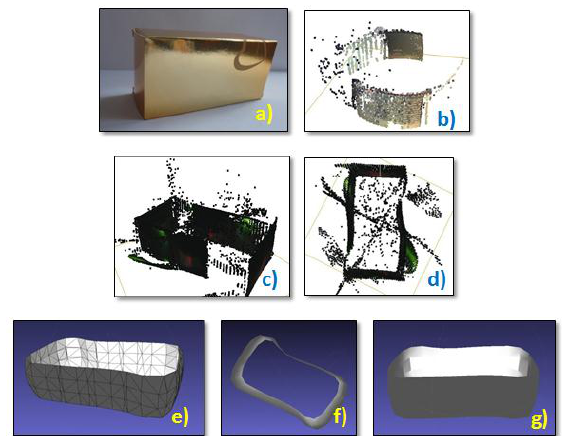
Figure 11. Paper box: a) photo of the real object; b) scanned cloud of points; c-d) scanned cloud of points without the daylight; e) processed data in form of TIN surface f-g) 3D